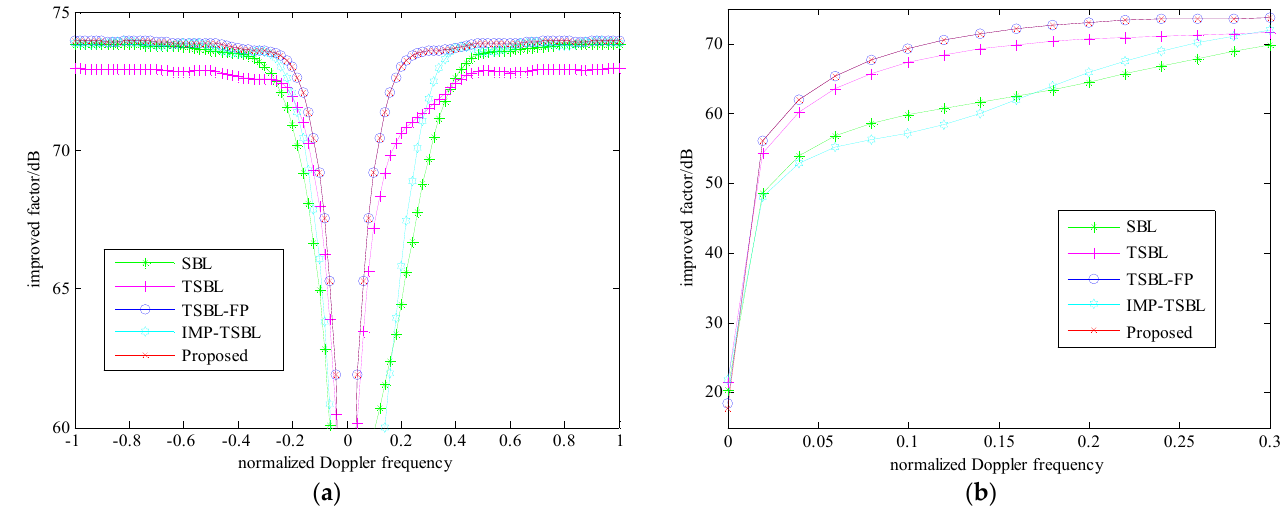
Figure 1. Improved factor (IF) against normalized Doppler frequency: ( a ) Local comparison in the vertical direction, ( b ) Local comparison in the horizontal direction.